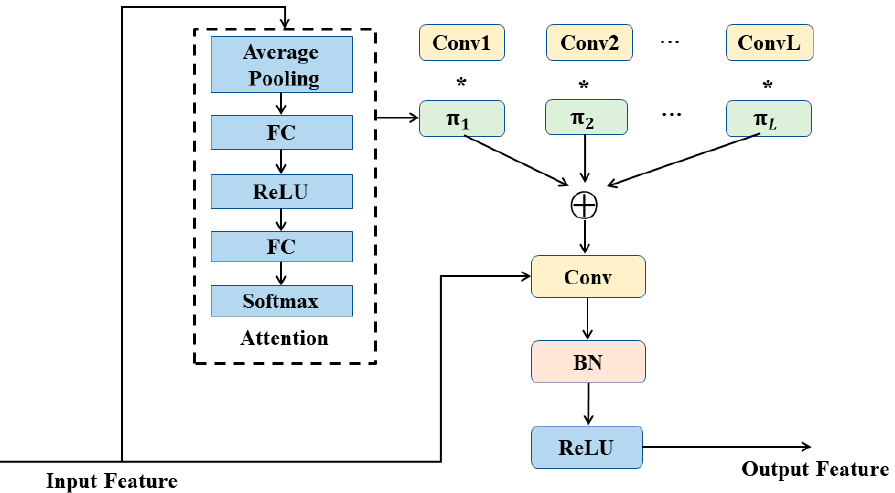
Figure 5. Dynamic convolution structure diagram.